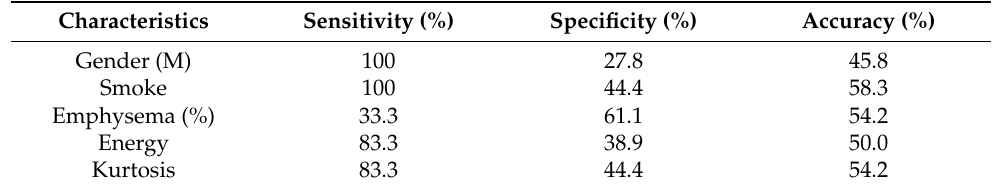
Table 5. Diagnostic accuracy in the validation cohort using cut-off values from the training